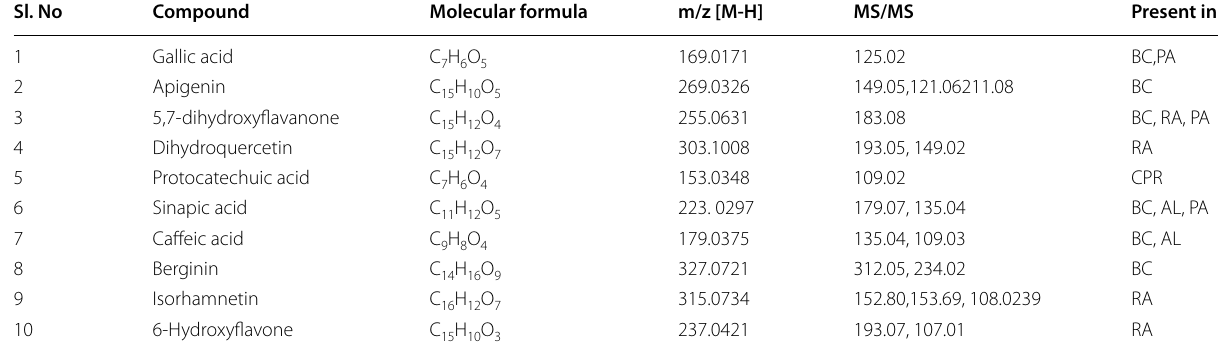
Table 3 LC/MS analysis of various source plants of Pashanabheda Sl. No